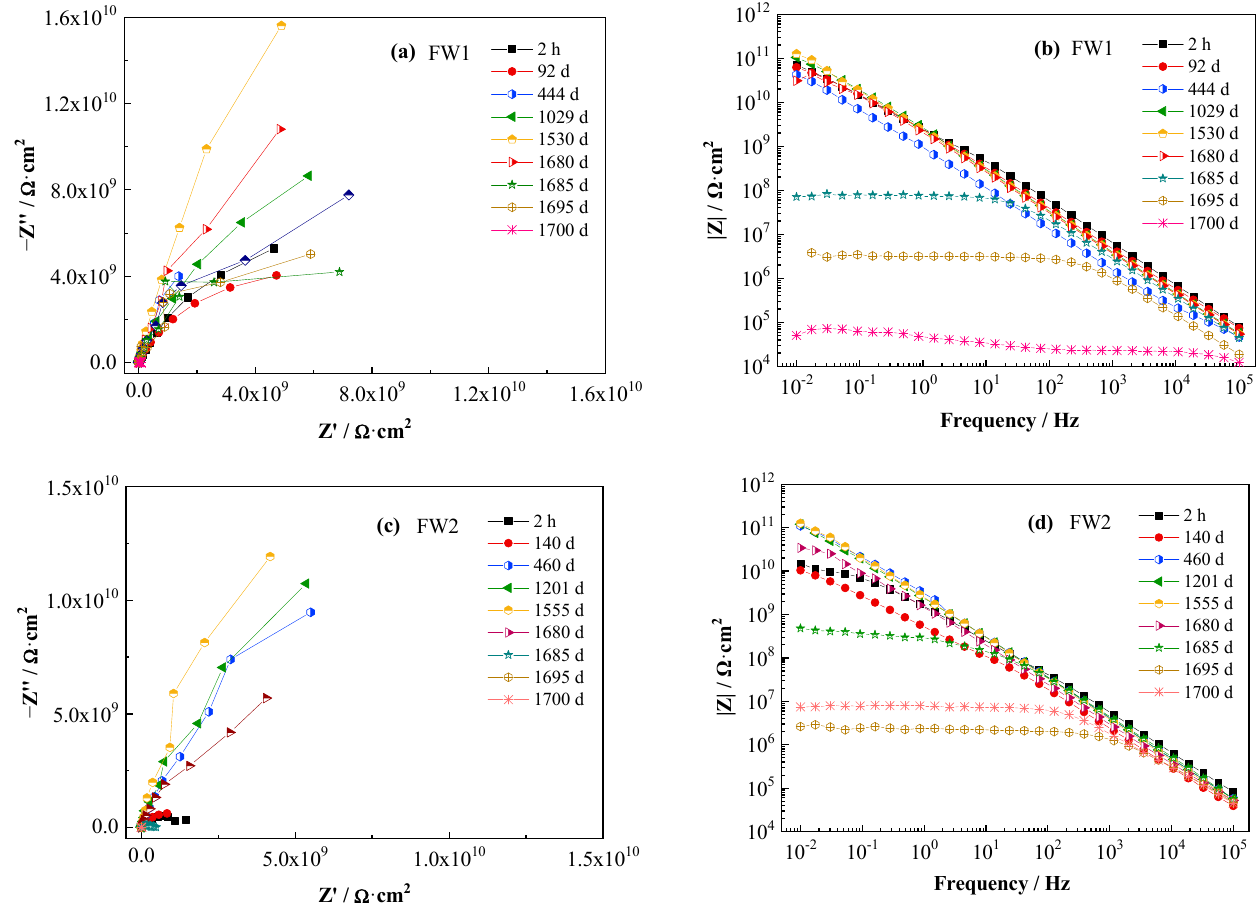
Figure 3. EIS spectra of two antifouling and anticorrosive coating samples: ( a , b ) FW1; ( c , d ) FW2.